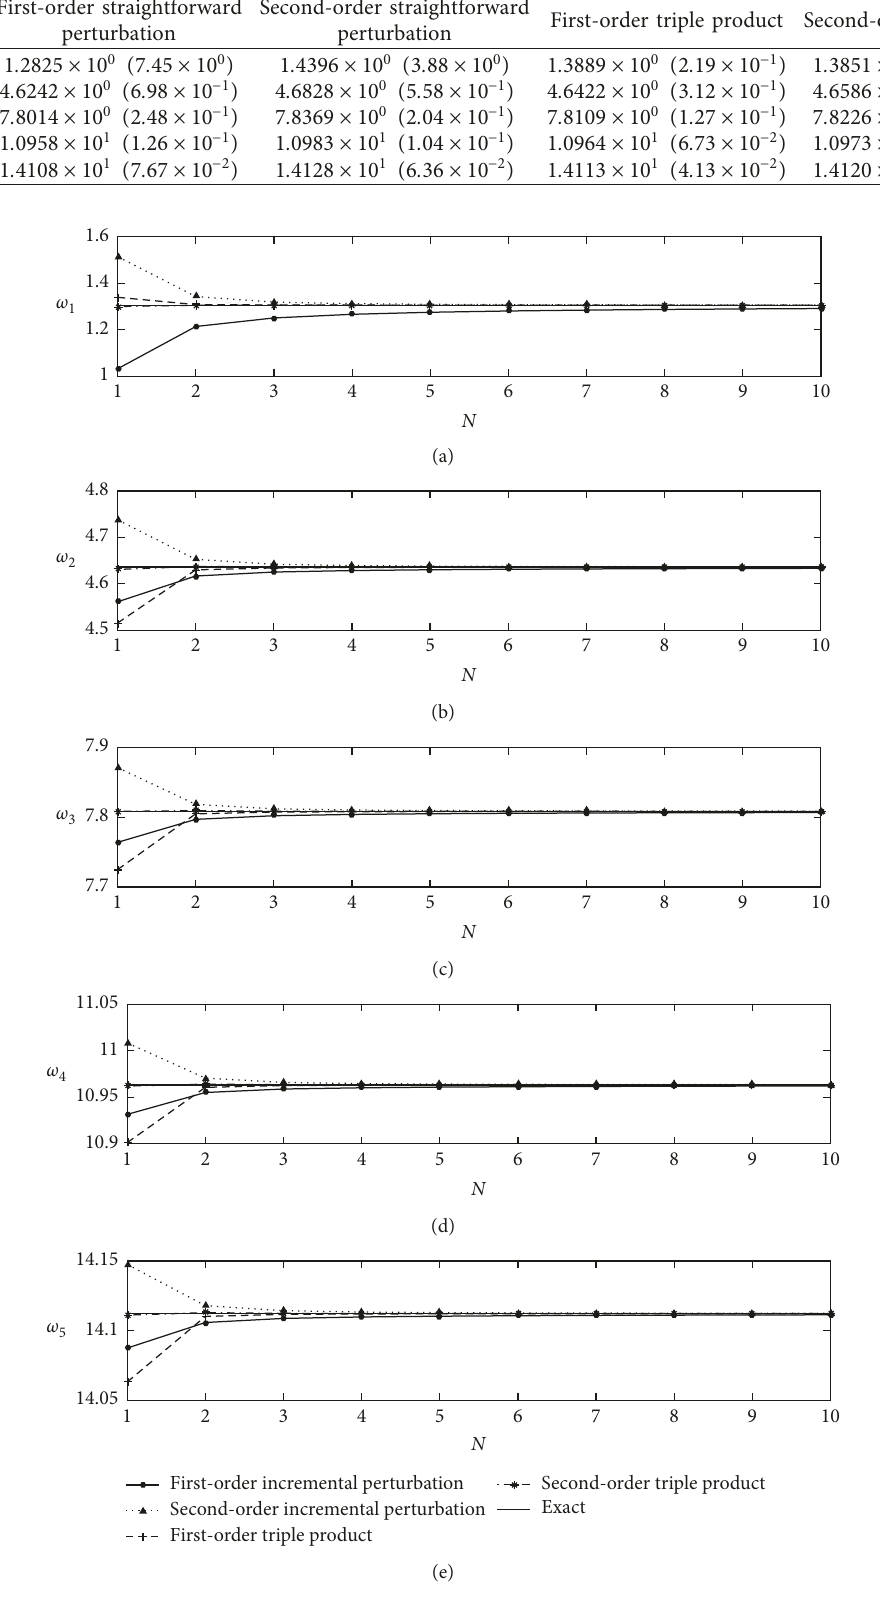
Figure 19: The approximate natural frequencies of the nonuniform rod as a function of N for a � 0 . 55. The natural frequencies are 􏽰 ������� E / ( ρ L 2 ) nondimensionalized by dividing by